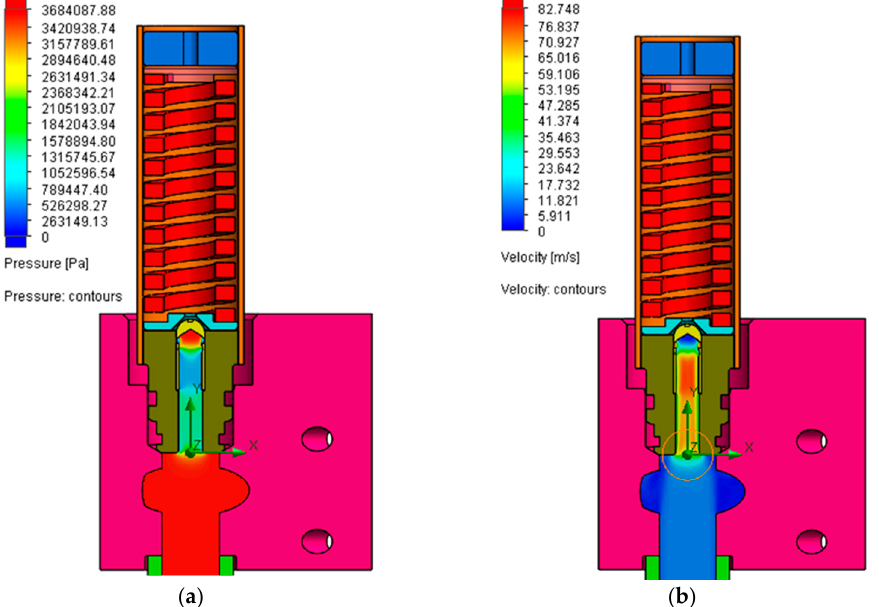
Figure 16. The variation maps of pressure ( p ) ( a ) and velocity ( υ ) ( b ) for a 0.0033 m 3 · s − 1 volume flow rate (200 L · min − 1